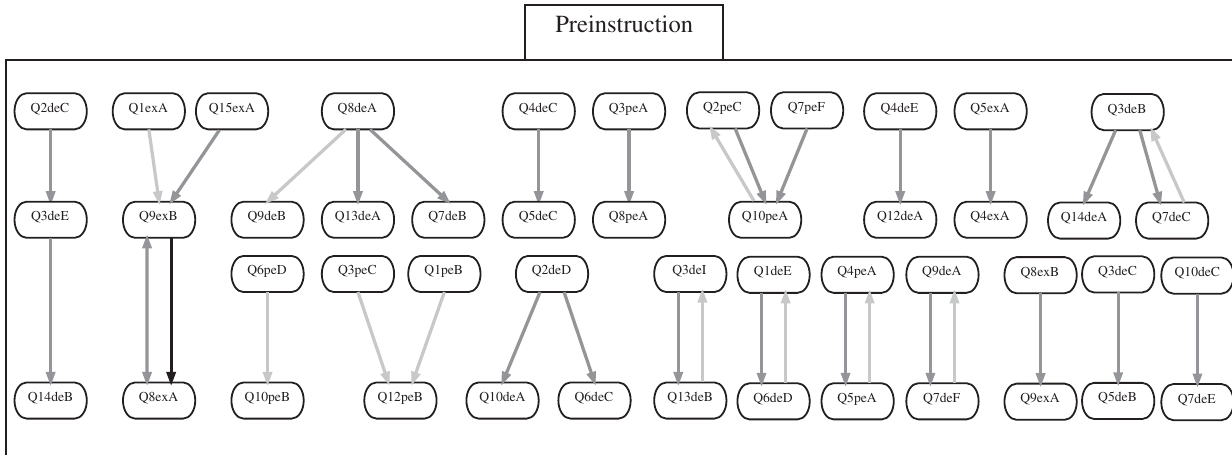
FIG. 5. Implicative graph for the answers to the questionnaire in preinstruction administration. Black arrows indicate an incidence of implication greater than 93% between two connected answers. The gray color is used to indicate implications between 90% and 93%; light gray arrows indicate an implication between 87% and 90%. In the upper panel, rectangles represent student answers to the questionnaire as reported and labeled in Appendix